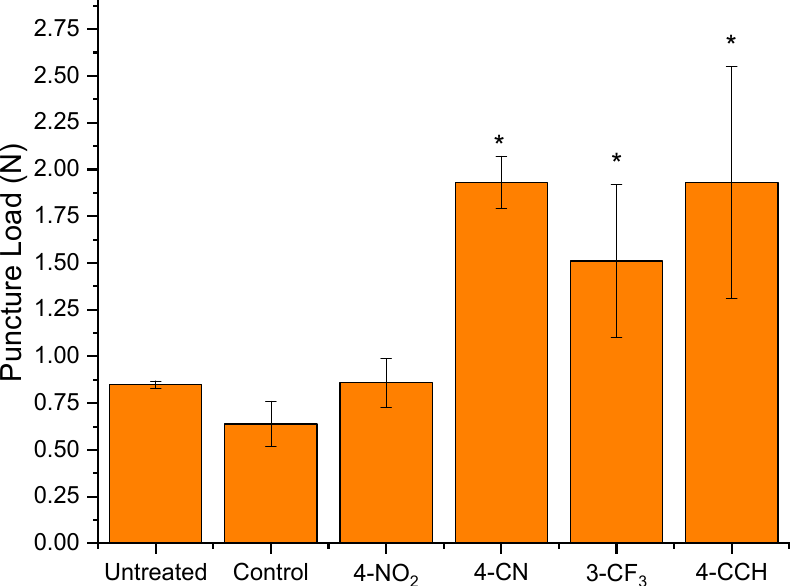
Figure 5. Puncture load (N) for all treated samples, including untreated and control samples. Errors are standard deviation, * denotes statistically significant difference to untreated sample, P < 0.05.